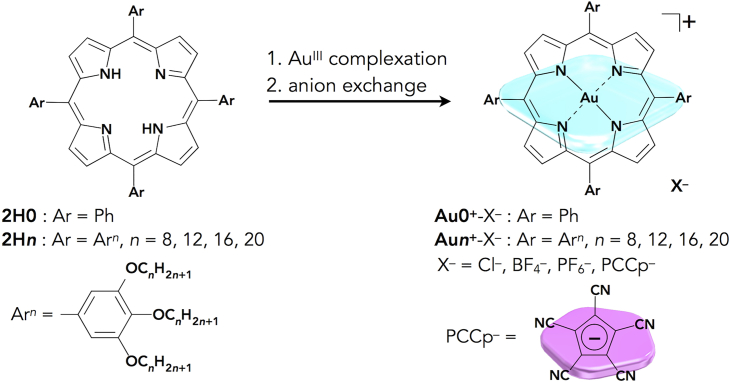
Synthesis of Porphyrin–AuIII-Based Ion PairsMeso-tetraarylporphyrin AuIII complexes: Au0+-X– (X– = Cl–, BF4–, PF6–, and PCCp–) and Aun+-X– (n = 8, 12, 16, and 20; X– = Cl–, BF4–, PF6–, and PCCp–).